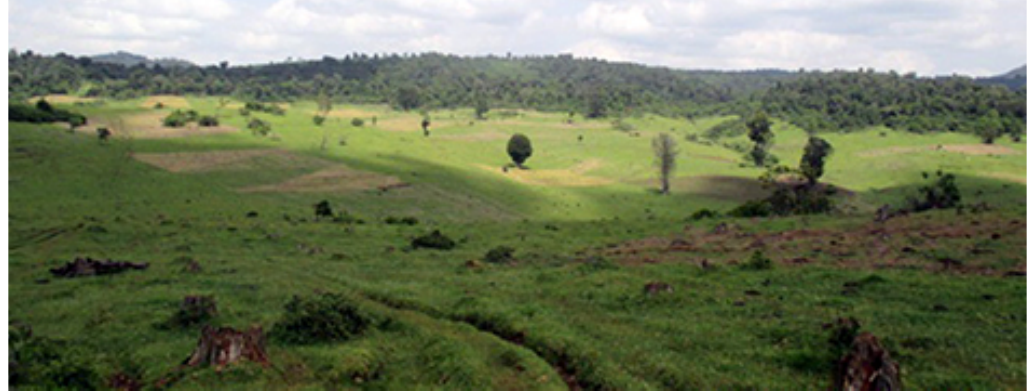
Figure 13. Part of the Chemususu Forest Block that underwent clear-cutting (Photo: Donald Kipruto Kimutai, 18 July 2015).